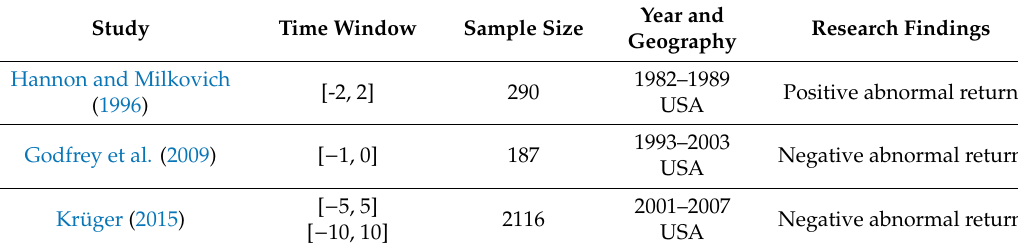
Table 2. Event studies in the category society.